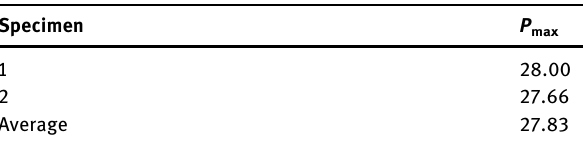
Table 3: Failure load of beams without corrosion ( unit: kN